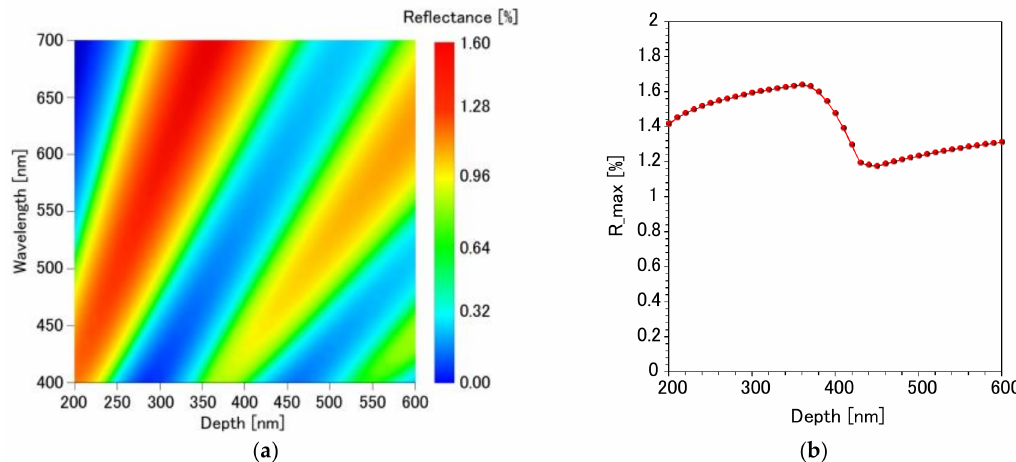
Figure 2. ( a ) Simulated reflection spectrum of the inverted moth-eye structure at various depths (200–600 nm) and incident light wavelengths (400–700 nm) The color bar indicates the reflectance values. ( b ) Dependence of the calculated maximum reflectance (R_max) in the visible light region on the depth of the inverted moth-eye structure.